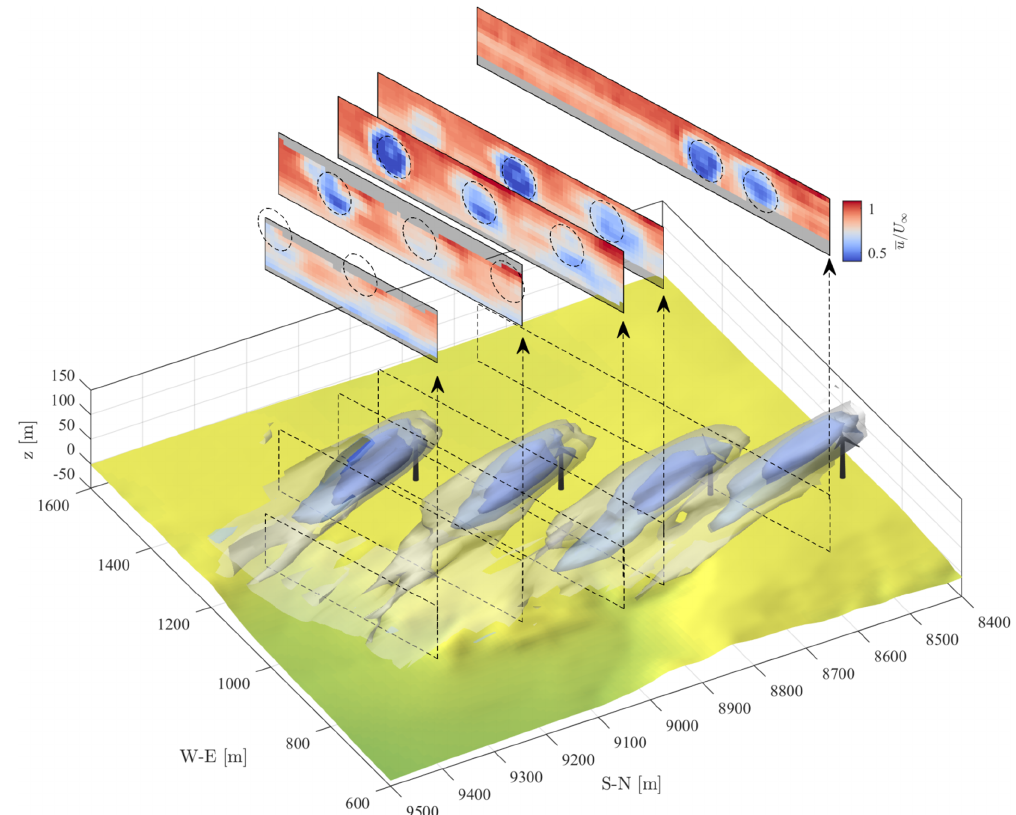
Figure 9. 3D rendering of the normalized mean equivalent velocity field reconstructed with (cid:49)θ w = 10 ◦ . The three isosurfaces represent u/U ∞ = 0 . 45, 0.6, and 0.75, while the color maps represent cross sections of the mean velocity field over the respective planes reported in the rendering. The dashed circles correspond to the rotor-swept area of turbines B16–B19 (from left to right) projected onto the specific